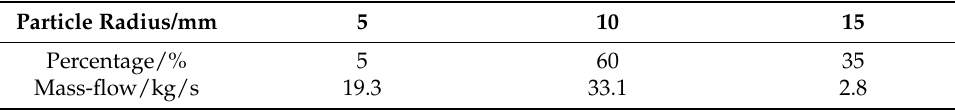
Figure 5. Working condition simulation of helical blade. Table 2. Particle size distribution of crushed stone aggregate.